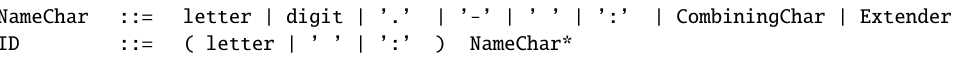
Figure 2.2: The definition of the type ID. The characters ( and ) are used for grouping, the character * indicates "zero or more times", and the character | indicates "or".